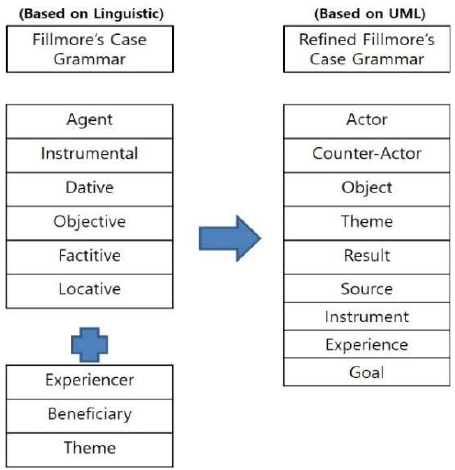
Figure 1. Refined Fillmore’s case mechanism.